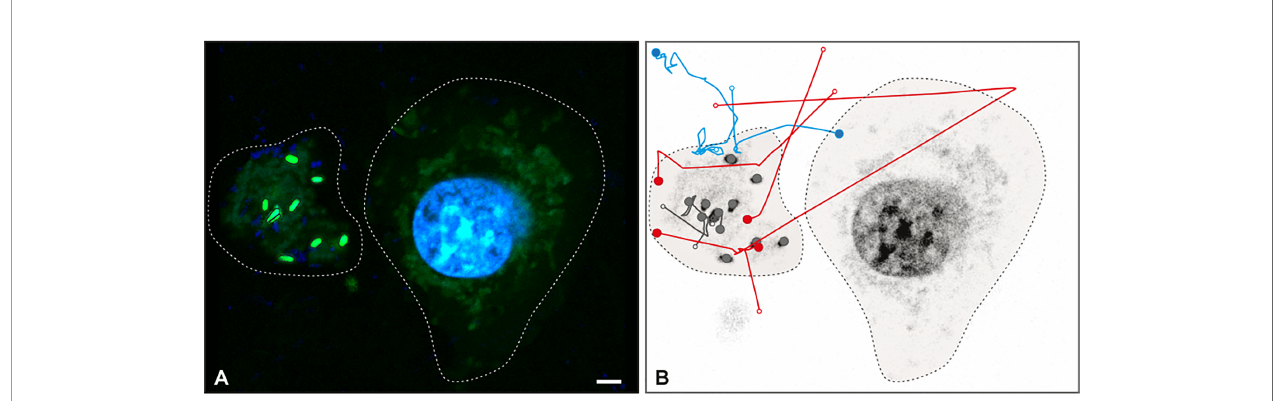
FIGURE 4 | Salmonella trapped in MET of J774A.1 macrophages. Live imaging was performed by confocal microscopy and Salmonella were tracked by image analysis. (A) Fluorescent image at t = 0 s with DNA (blue) and Salmonella (green) channels shows a J774A.1 macrophage (dashed line on the right) and a MET (dashed line on the left). Within the MET, 9 bacteria with high intensity values were identi fi ed. (B) Inverse grey scale color table for DNA channel is shown for t = 231 s together with the 15 tracked trajectories for Salmonella. The positions of each bacterium at the beginning and the end of the trajectory are marked by an open and closed circle, respectively. Trajectory lines are colored according to bacteria status: trapped within the MET (grey); free and later trapped (red) and transiently trapped (blue). Trajectories of swimming bacteria are not displayed. The scale bar represents 10 µm.